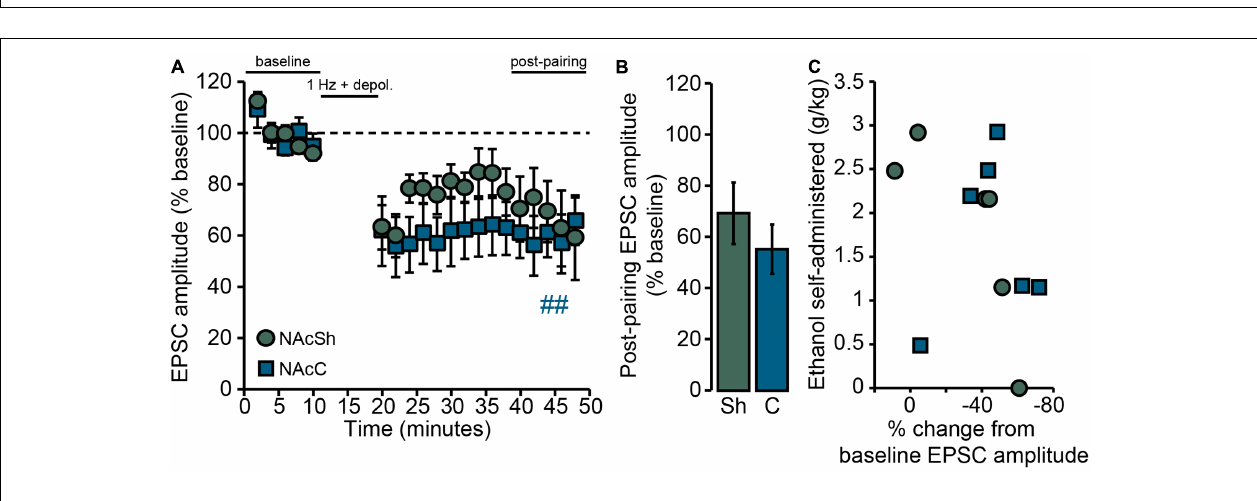
FIGURE 5 | Loss of LTD in NAcSh D1MSNs following operant self-administration of ethanol is correlated with ethanol consumption. (A) Data points are group means ( ± SEM) for normalized (% baseline) EPSC amplitudes averaged in 2-min bins; NAcSh: n = 6 cells, five mice; NAcC: n = 6 cells, six mice. Half of all cells were pairs of recordings made in two different slices (one core, one shell) from the same mouse. ## p = 0.005 for NAcC post-pairing vs. baseline period. (B) Bars show group means ( ± SEM) for normalized EPSC amplitudes averaged over the entire 10-min post-pairing period. (C) Data points are individual observations for the cells that comprise the group data shown in (A,B) . For NAcSh D1MSNs (circles) there was a strong, inverse correlation between ethanol consumption during the final operant self-administration session and the magnitude of LTD expressed 24 h later ( r s = –0.93, p = 0.008). NAcC D1MSNs (squares) did not show such a relationship ( r s = 0.09,